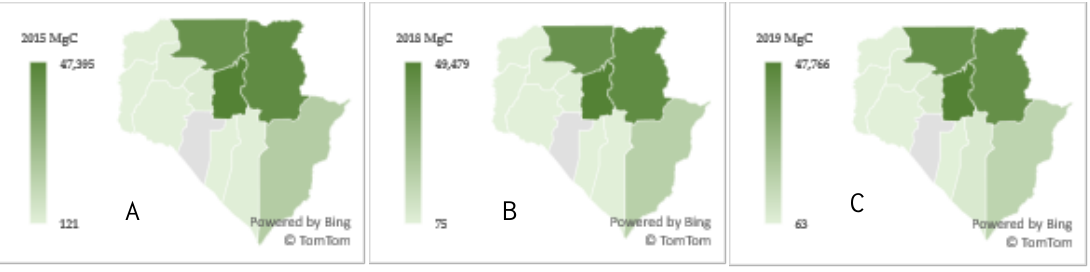
Figure 15. Maps showing carbon stock distribution at the district level using Landsat OLI data ( A ) in 2015 and ( B ) in 2018, while ( C ) used Sentinel-2 data in 2019.